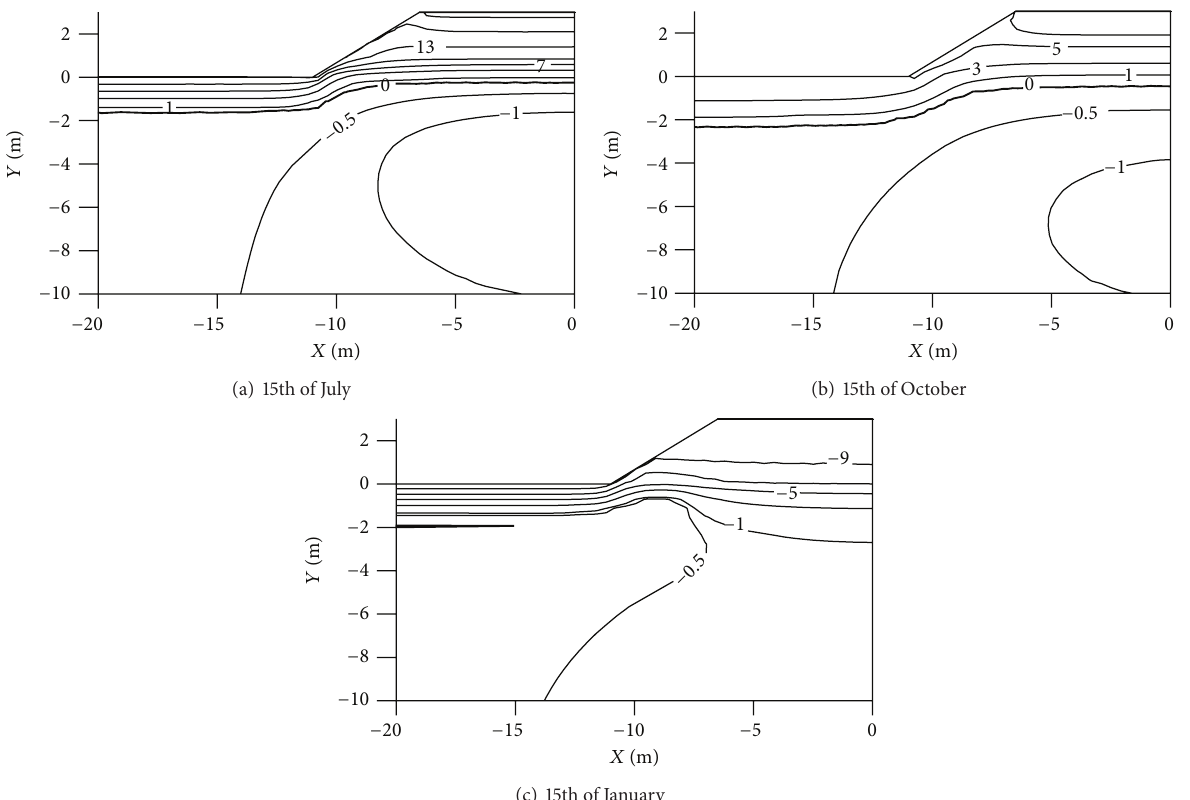
Figure 8: Temperature field of the duct-ventilated and closed crushed-rocks embankment after 50 years of